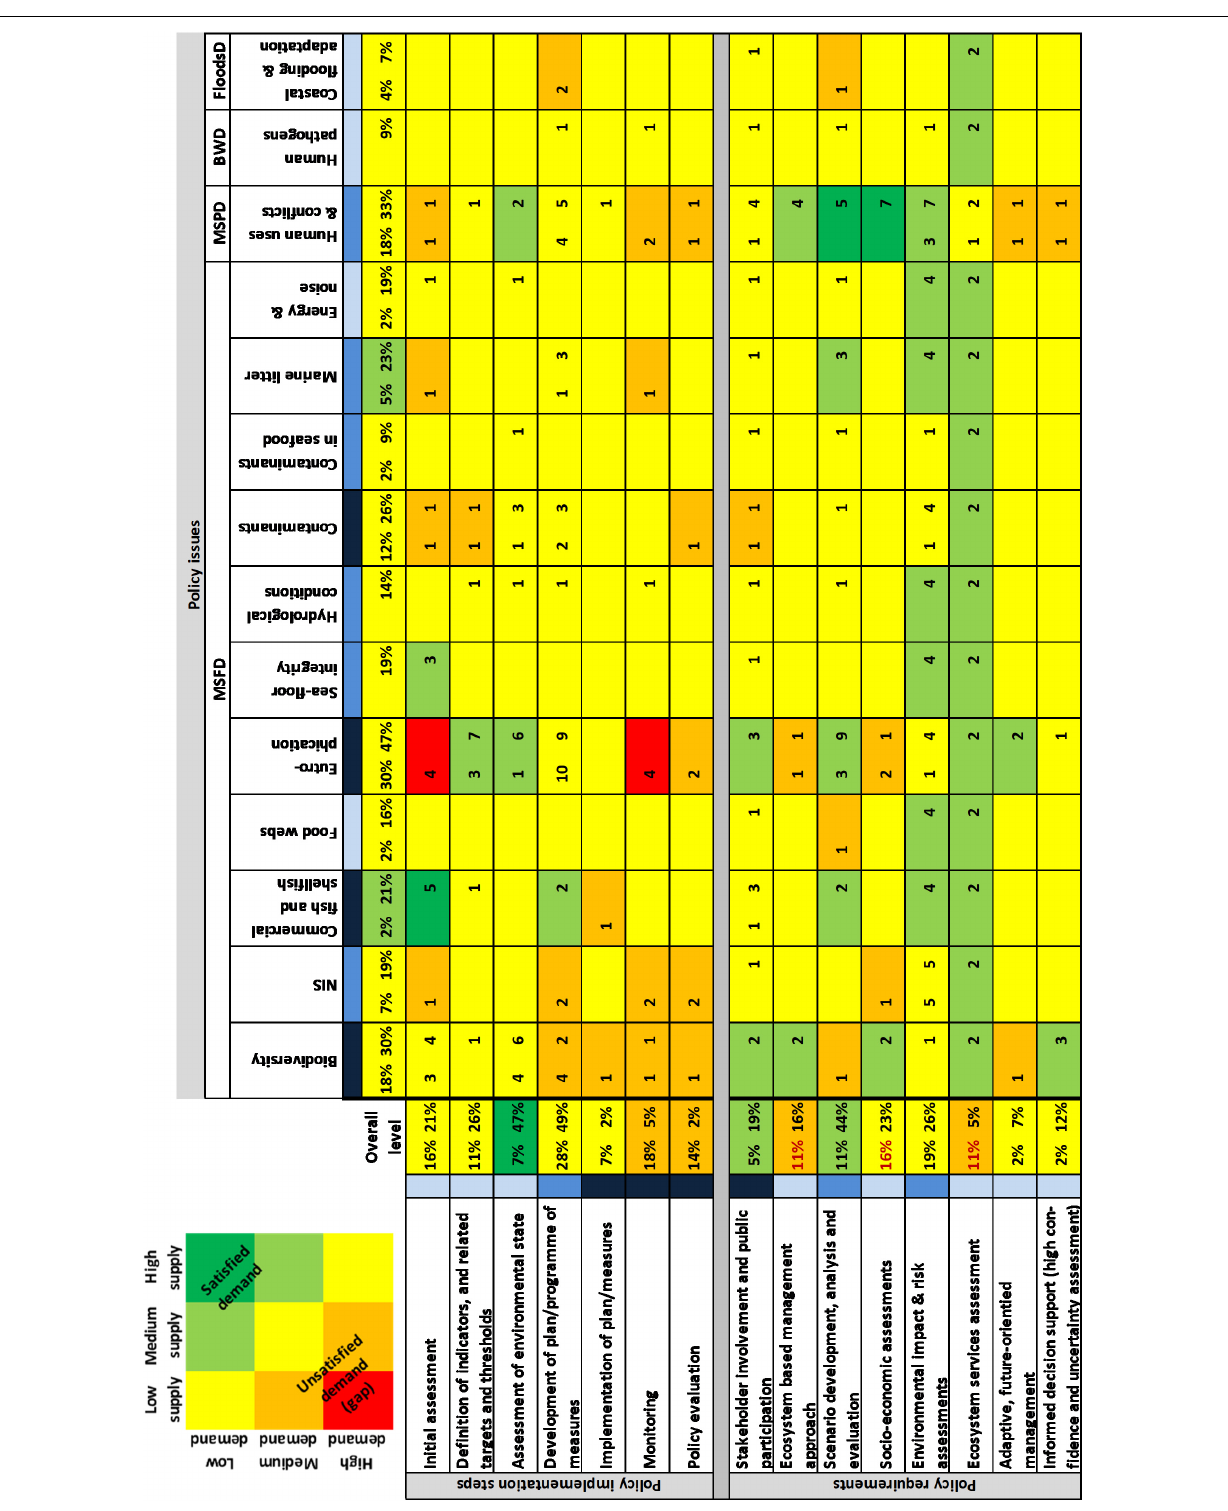
Frontiers in Marine Science |